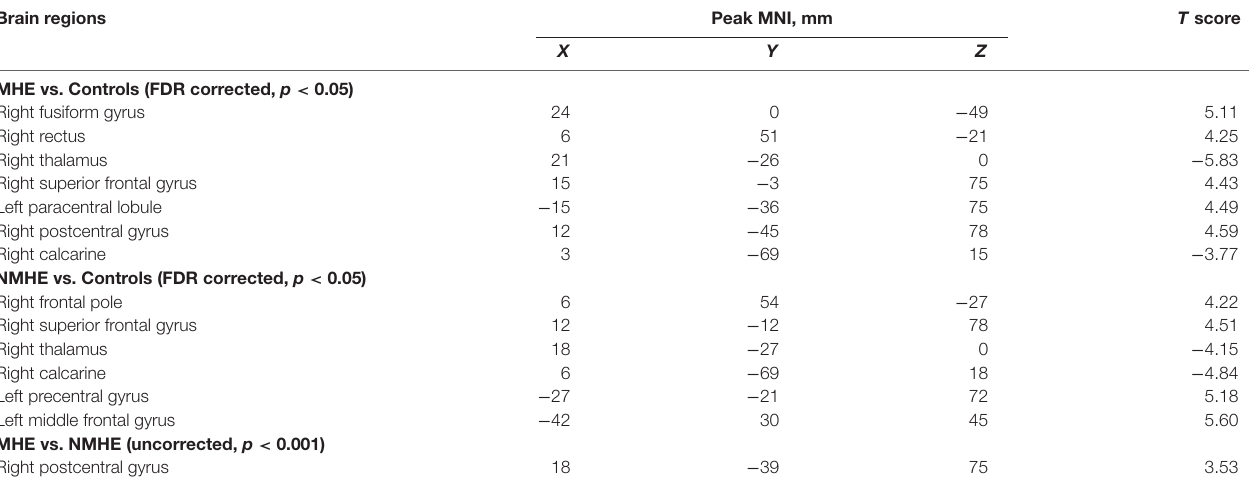
TABLE 3 | Brain areas showing different regional homogeneity between each pair of the three groups. Brain